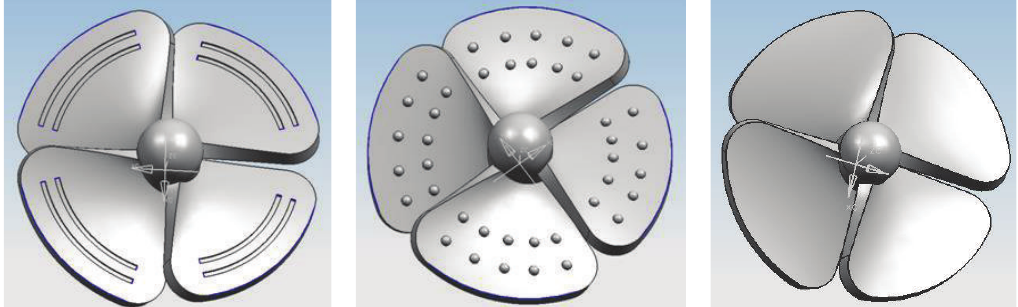
Figure 2: The geometrized structure graph of axial fan